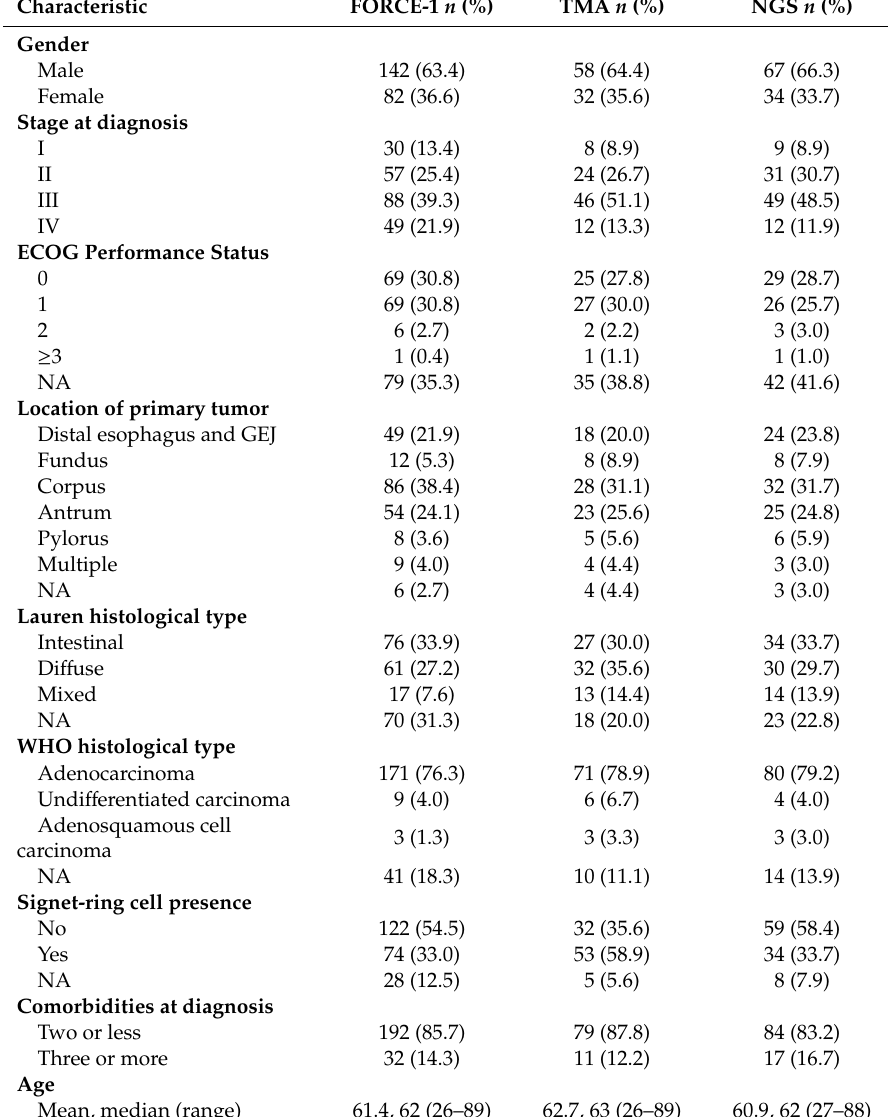
Table 1. Demographic and clinico-pathological characteristics of FORCE-1 study population ( n =